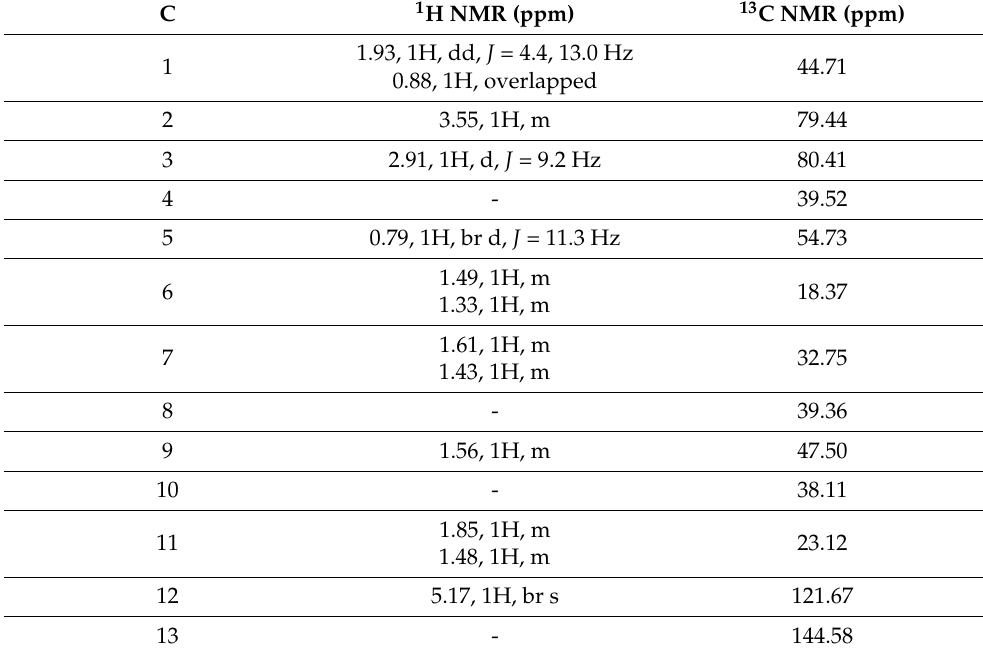
Table 1. 1 H- and 13 C-NMR spectral of maslinic acid-2-O- β -D-glucose (dimethylsulfoxide-D6, 400 MHz).